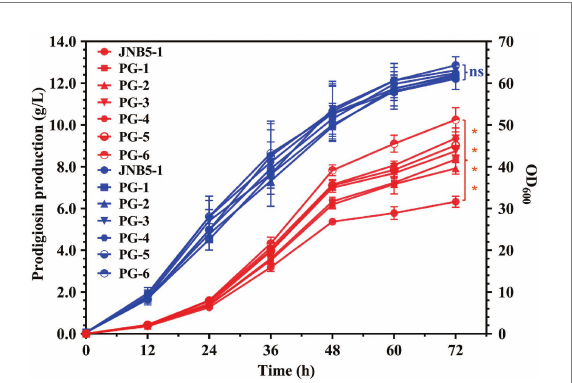
FIGURE 4 Prodigiosin production and cell growth curve of strains JNB5-1, PG-1, PG-2, PG-3, PG-4, PG-5, and PG-6 in fermentation medium. Red lines indicate the prodigiosin production and blue lines indicate biomass (OD 600 ). JNB5-1 is a prodigiosin producing strain isolated form soil samples. PG-1 is a prodigiosin producing recombinant strain constructed by overexpression of psrA gene under the control of its own promoter P PsrA via the plasmid pUCP18 in strain JNB5-1. PG-2 is a prodigiosin producing recombinant strain constructed by overexpression of ompR gene under the control of its own promoter P OmpR via the plasmid pUCP18 in strain JNB5-1. PG-3 is a prodigiosin producing recombinant strain constructed by overexpression of ompR gene under the control of its own promoter P OmpR and psrA gene under the control of its own promoter P PsrA via the plasmid pUCP18 in strain JNB5-1. PG-4 is a prodigiosin producing recombinant strain constructed by overexpression of psrA gene under the control of the promoter P17 (P RplJ ) via the plasmid pUCP18 in strain JNB5-1. PG-5 is a prodigiosin producing recombinant strain constructed by overexpression of ompR gene under the control of the promoter P17 (P RplJ ) via the plasmid pUCP18 in strain JNB5-1. PG-6 is a prodigiosin producing recombinant strain constructed by overexpression both of ompR and psrA genes under the control of the promoter P17 (P RplJ ) via the plasmid pUCP18 in strain JNB5-1. PsrA and OmpR are two prodigiosin synthesis activators in strain JNB5-1. The experiments were performed in biological triplicates. Error bars indicate the standard deviations. One-way analysis of variance (ANOVA) was used to examine the mean differences between the data groups. **** p < 0.001; ns, no significance